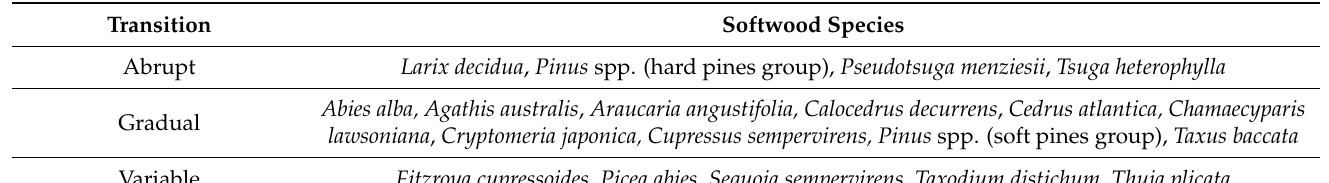
Table 7. Examples of species for different types of transition in softwoods.